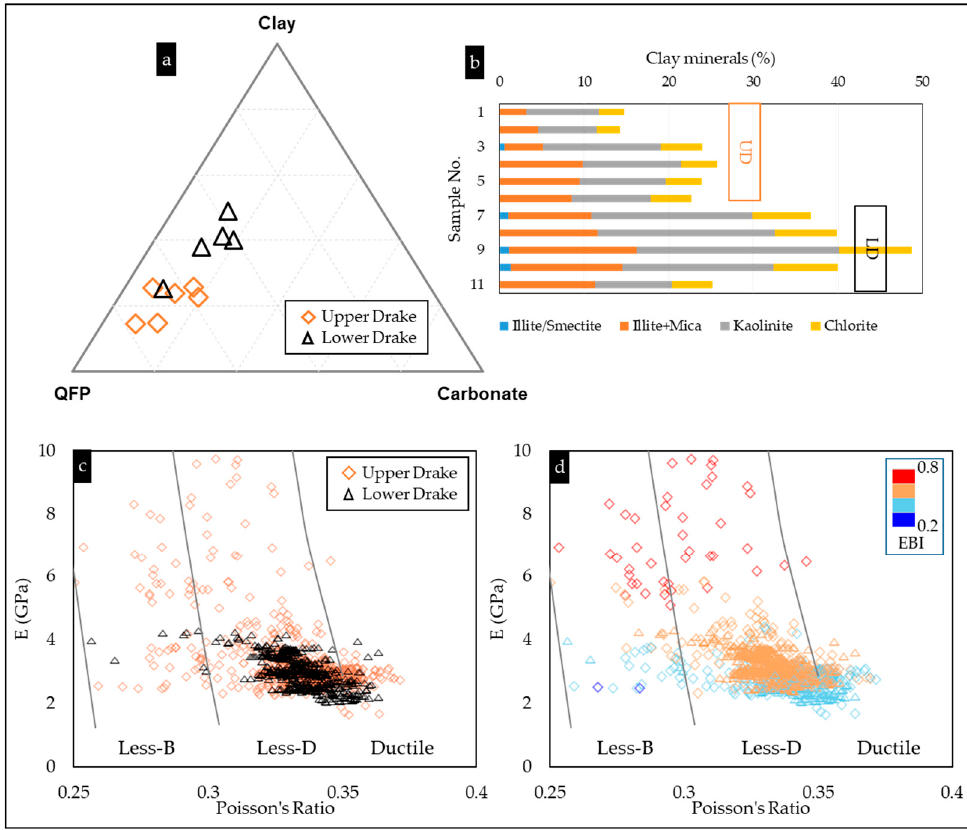
Figure 17. Bulk mineralogy from upper and lower Drake units from well 31/5-2 shows the upper and lower Drake unit variations of mineralogical composition ( a ) and clay mineralogy ( b ) [29]. The log-based geomechanical properties are color-coded with units from the same well ( c ) and EBI ( d ). The background curves are adapted from Perez and Marfurt [50].